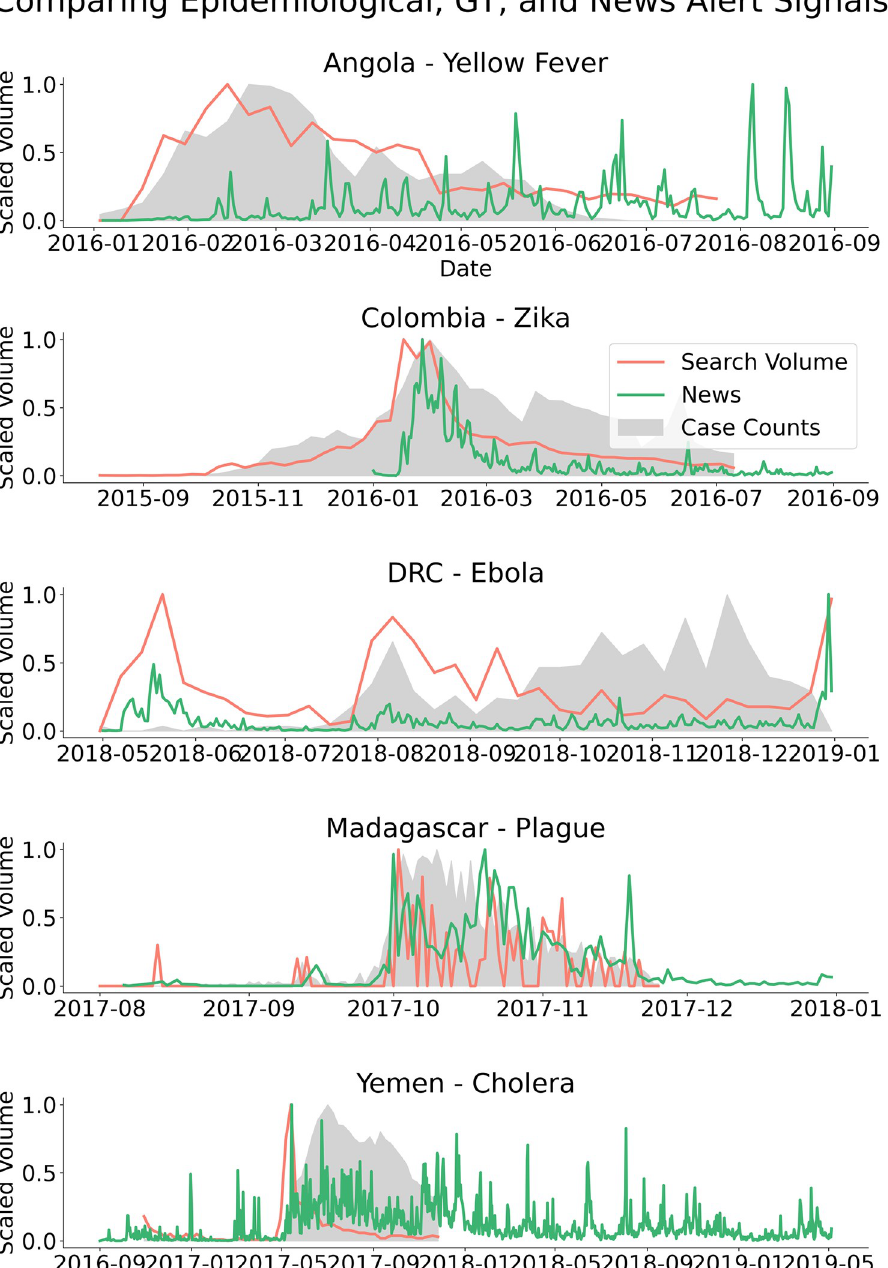
Fig 5. Comparison of signals in ground-truth epidemiological data, Google search query volumes, and news alerts data from the GDELT Global Knowledge Graph. Note how media coverage (as captured in the news alerts time- series) may bias predictions based on the GT data. Search term signals are drawn from the same search term as in Fig 1.